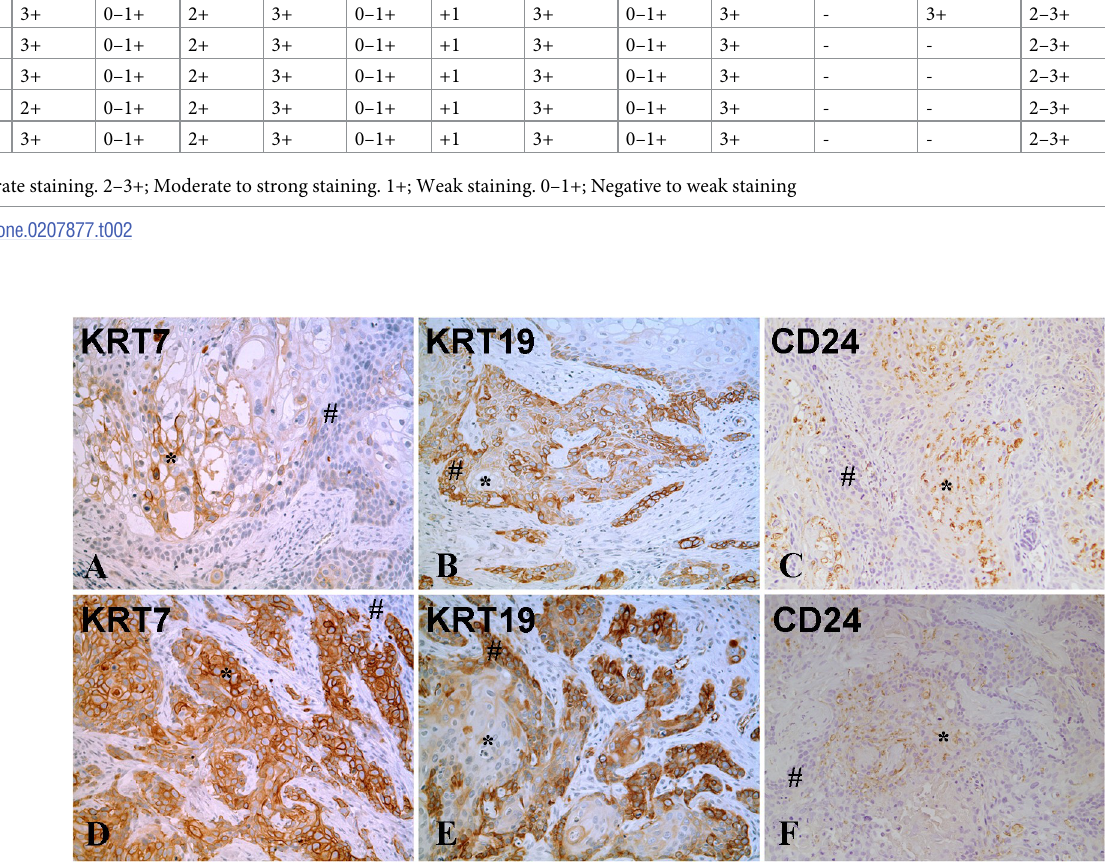
Fig 5. Immuno-histochemical staining for luminal markers in tumor transplants generated from the As 3+ -transformed cell line (As#2) and the Cd 2+ -transformed cell line (Cd#3). (A-C). As#2. (A). KRT7. There is strong staining in the well- differentiated cells in the center of the tumor nests ( � ) whereas the peripheral less differentiated cells (#) are negative. (B). KRT19. There is strong staining in the less differentiated cells (#) located at the periphery while the center of the tumor nests with well- differentiated cells ( � ) are weakly positive. (C). CD24. There is moderate to strong granular staining in the well-differentiated cells ( � ) located in the center of the tumor nests whereas the peripheral less differentiated cells (#) are negative for CD24. (D-F). Cd#3. (D). KRT7. There is strong staining in the well-differentiated cells in the center of the tumor nests ( � ) whereas the peripheral less differentiated cells (#) are negative. (E). KRT19. There is strong staining in the less differentiated cells (#) located at the periphery while the center of the tumor nests with well-differentiated cells ( � ) are weakly positive or negative. (F). CD24. There is moderate to strong focal granular staining in some well-differentiated cells ( � ) in the center of tumor nests, whereas the peripheral less differentiated cells (#) are negative for CD24. The brown color indicates the presence of the protein whereas the blue/purple color indicates the nuclei that are stained with the counterstain hematoxylin. All images are at a magnification of 200X.